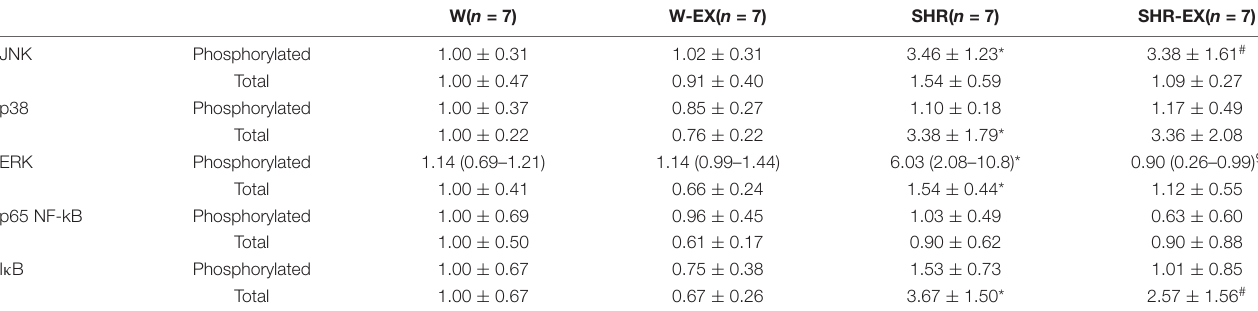
TABLE 8 | Protein expression.